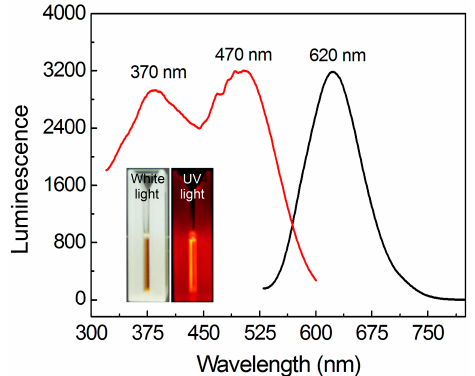
Figure 1. Photoluminescence of the as-prepared AuNCs in the present work. The excitation spectrum shows two peaks at 370 and 470 nm, respectively. The maximal emission peak is located at 620 nm. The inset shows the digital photos of the AuNCs solution under sunlight and 365-nm UV light, respectively.